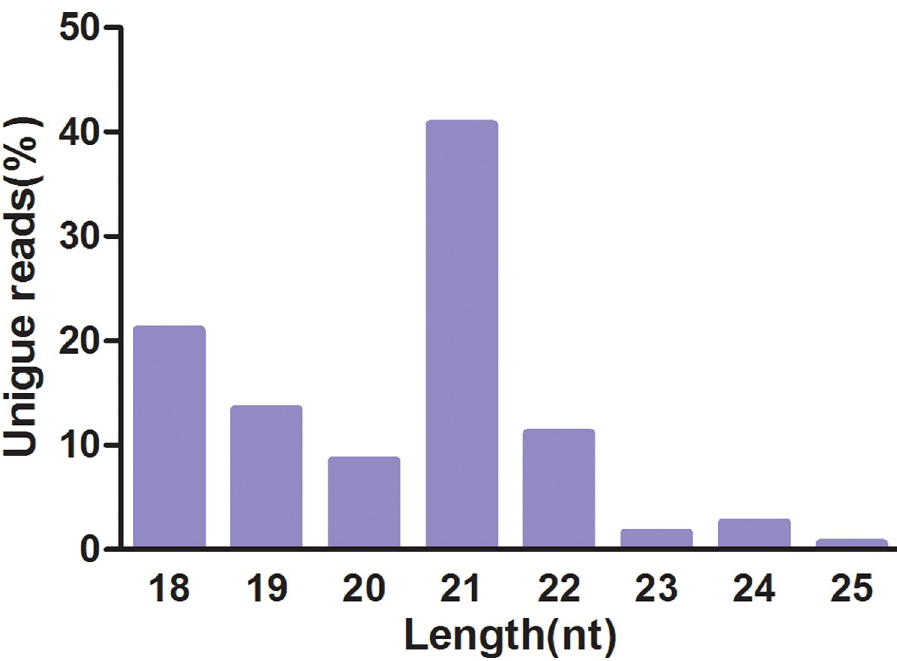
Fig 5. Length distributions of unique